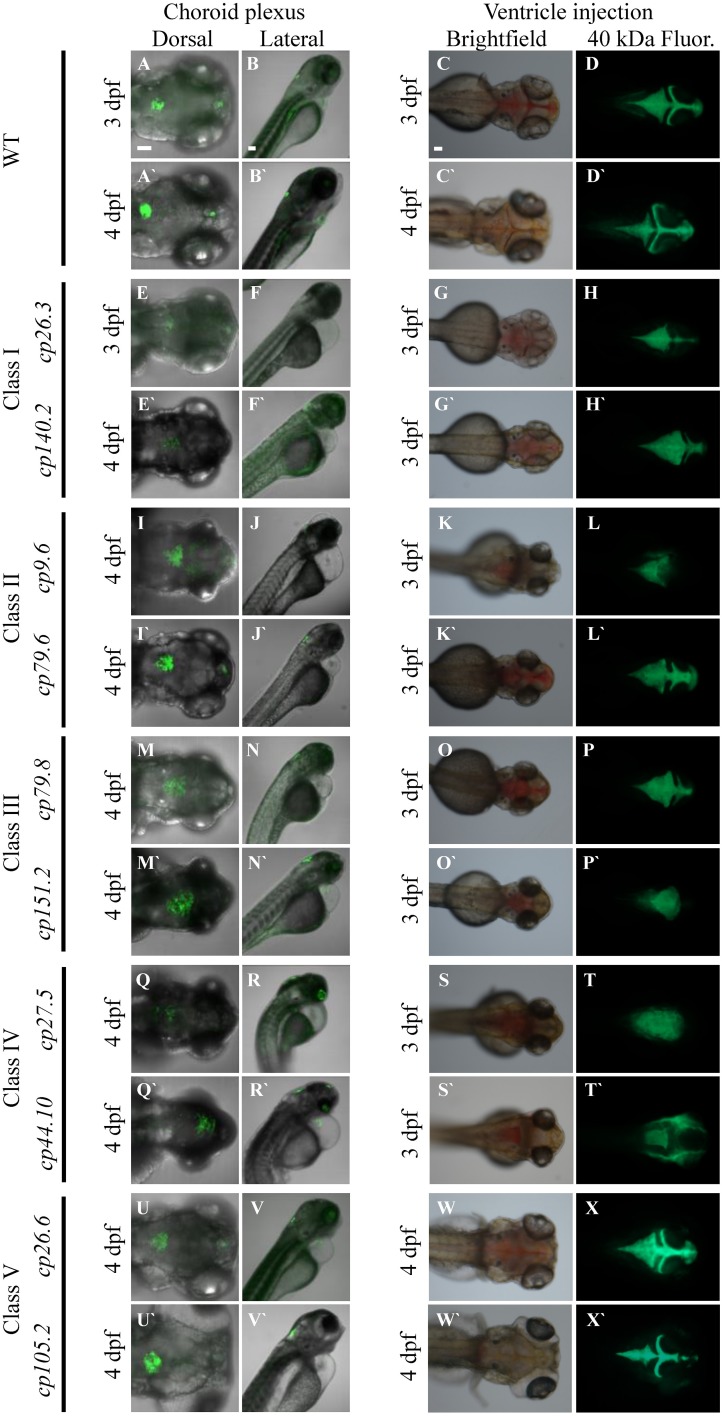
Forward genetic screen identifies five classes of CP mutants. (A–B′) Wild-type Et(cp:EGFP)sj2 larvae at 3 dpf and 4 dpf. (C–C′) Bright field image of 3 and 4 dpf wild-type after ventricle injection of the 40-kDa fluorescein dextran. (D–D′) Fluorescent image of 3 and 4 dpf wild-type after ventricle injection of the 40-kDa fluorescein dextran. Class I: (E,F)
cp26.3 at 3 dpf. (E′,F′)
cp140.2 at 4 dpf. (G) Bright field image of cp26.3 at 3 dpf after ventricle injection of the 40-kDa fluorescein dextran. (G′) Bright field image of cp140.2 at 3 dpf after ventricle injection of the 40-kDa fluorescein dextran. (H) Fluorescent image of cp26.3 at 3 dpf after ventricle injection of the 40-kDa fluorescein dextran. (H′) Fluorescent image of cp140.2 at 3 dpf after ventricle injection of the 40-kDa fluorescein dextran. Class II: (I,J)
cp9.6 at 4 dpf. (I′,J′)
cp79.6 at 4 dpf. (K) Bright field image of cp9.6 at 3 dpf after ventricle injection of the 40-kDa fluorescein dextran. (K′) Bright field image of cp79.6 at 3 dpf after ventricle injection of the 40-kDa fluorescein dextran. (L) Fluorescent image of cp9.6 at 3 dpf after ventricle injection of the 40-kDa fluorescein dextran. (L′) Fluorescent image of cp79.6 at 3 dpf after ventricle injection of the 40-kDa fluorescein dextran. Class III: (M,N)
cp79.8 at 4 dpf. (M′,N′)
cp151.2 at 4 dpf. (O) Bright field image of cp79.8 at 3 dpf after ventricle injection of the 40-kDa fluorescein dextran. (O′) Bright field image of cp151.2 at 3 dpf after ventricle injection of the 40-kDa fluorescein dextran. (P) Fluorescent image of cp79.8 at 3 dpf after ventricle injection of the 40-kDa fluorescein dextran. (P′) Fluorescent image of cp151.2 at 3 dpf after ventricle injection of the 40-kDa fluorescein dextran. Class IV: (Q,R)
cp27.5 at 4dpf. (Q′,R′)
cp44.10 at 4 dpf. (S) Bright field image of cp27.5 at 3 dpf after ventricle injection of the 40-kDa fluorescein dextran. (S′) Bright field image of cp44.10 at 3 dpf after ventricle injection of the 40-kDa fluorescein dextran. (T) Fluorescent image of cp27.5 at 3 dpf after ventricle injection of the 40-kDa fluorescein dextran. (T′) Fluorescent image of cp44.10 at 3 dpf after ventricle injection of the 40-kDa fluorescein dextran. Class V: (U,V)
cp26.6 at 4 dpf. (U′,V′)
cp105.2 at 4 dpf. (W) Bright field image of cp26.6 at 4 dpf after ventricle injection of the 40-kDa fluorescein dextran. (W′) Bright field image of cp105.2 at 4 dpf after ventricle injection of the 40-kDa fluorescein dextran. (X) Fluorescent image of cp26.6 at 4 dpf after ventricle injection of the 40-kDa fluorescein dextran. (X′) Fluorescent image of cp105.2 at 4 dpf after ventricle injection of the 40-kDa fluorescein dextran. The first, third, and fourth panels for each class are dorsal views while the second panel is a lateral view. The first and second panels for each class were acquired by confocal microscopy. The third and fourth panels were acquired by fluorescent stereoscopy. The first panel for each class is at 20× magnification, the second panel is at 10× magnification, and the third and fourth panels are at 16× magnification. 40 kDa Fluor, 40 kDa Fluorescein Dextran. Scale bars in A, B, and C are 50 μm.